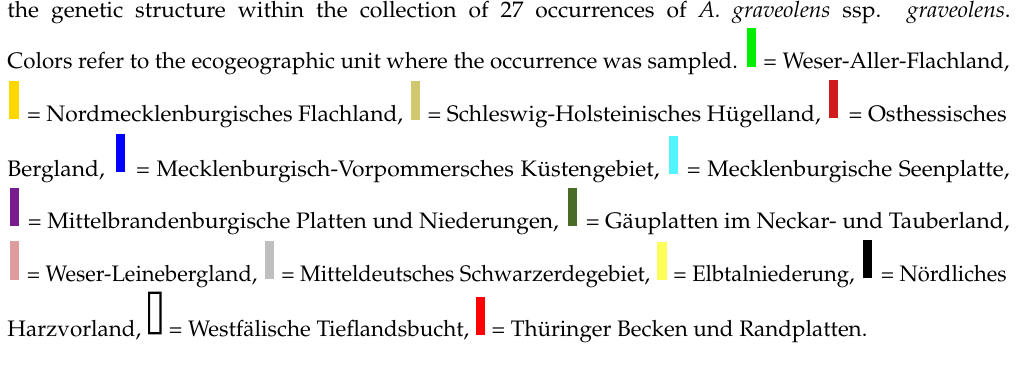
Figure 2. Map showing the locations of the 27 occurrences. A black triangle marks the 15 Most Appropriate Wild Populations (MAWP) while a black dot marks the remaining 12 occurrences. The location names are given in Table 1. The application of the genetic reserve conservation technique requires the choice of populations on the basis of the genetic representativity or uniqueness in relation to all analyzed populations [41]. In seed propagated species, under natural conditions, the parent population passes genes or gene complexes with their specific alleles to the next generation. Therefore, the recommendation of populations for conservation of a seed propagated species has to be based on the analyses of compositional genetic differentiation ( Δ j ) at the gene pool level. Next to Δ j , quality criteria for genetic reserves suggested by Iriondo et al. [32] were applied to identify MAWP (Table 1). The measure Δ j , marked in the snail diagram by the radius length of a sector, was calculated to assess the contribution of each occurrence to genetic differentiation. The result is summarized in Figure 3. The mean genetic differentiation Δ SD is the average of the 27 radii and is marked by the circle in the diagram. The mean complementary genetic differentiation is Δ SD = 0.3688. AgHEC ( Δ j = 0.2513) represents the genetic composition of the pooled remaining 26 occurrences best while the genetic composition of AgWA ( Δ j = 0.4776) deviates from its complement most. The Δ j values of the other 25 occurrences decreases in small steps clockwise from AgG to AgROS. The difference between the Δ j - values of two occurrences depicted next to each other in clockwise sense is never larger than 0.034, i.e., less than 3.4% of the maximal possible sector radius length, and for most of the occurrences (20 out of 27) smaller than 1%. This means that neighbouring occurrences differ only slightly in their contribution to genetic differentiation. The genetic reserve conservation technique includes by definition the active management of a MAWP. Knowledge of the reproductive system of the species is required to understand how site management interventions influence the genetic composition and the development of genetic